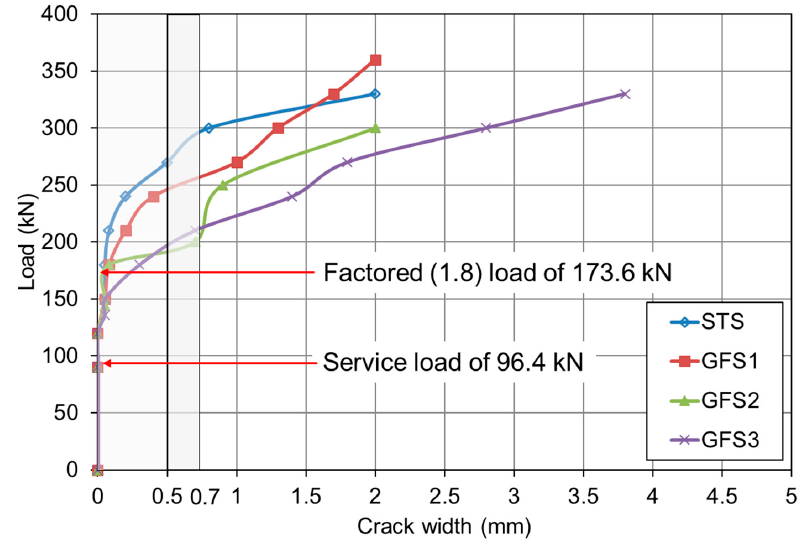
Figure 8. Measured load and crack width relationships of STS and GFS specimens.